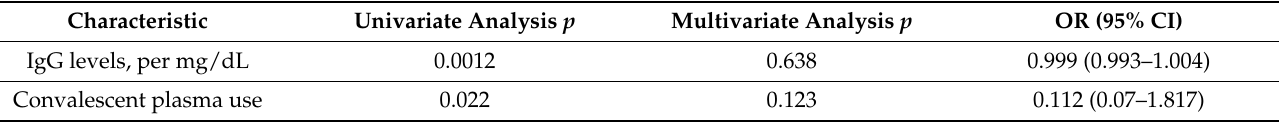
Table 4. Regression analysis of re-admission among patients who